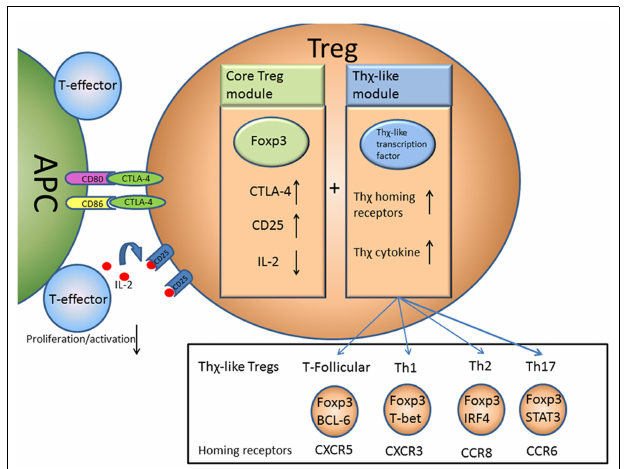
FIGURE 1 |A two module model ofTreg function. Foxp3 acts to control the core module ofTreg suppressive function by regulating expression of a number of key molecules such as CTLA-4 and CD25.This allowsTregs to suppressT-effector activation and proliferation by suppressing APC function via CTLA-4 and possibly depriving IL-2 from otherT cells. An additional Th χ -like module of suppressive function may also be induced that causes Tregs to expressTh χ -like transcription factors allowing theTregs to take on some of the properties ofTh1,Th2,Th17, or follicularT cells, travel to the same sites and deliver in situ